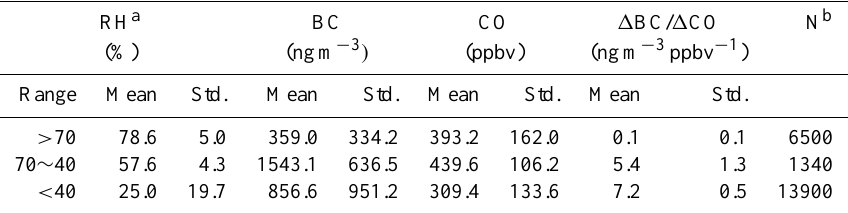
Table 3. Relationship between the 1 BC/ 1 CO ratio and RH for all data.